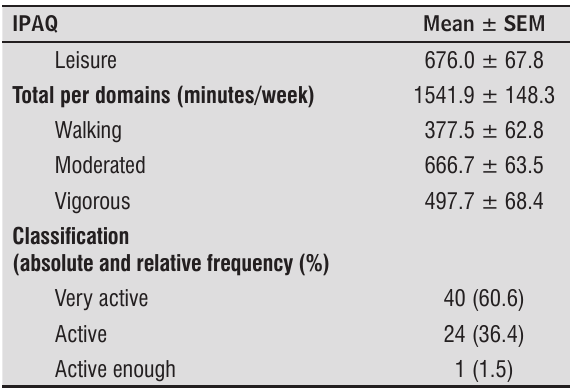
Table 2 - Levels of physical activity of participants (n = 66)